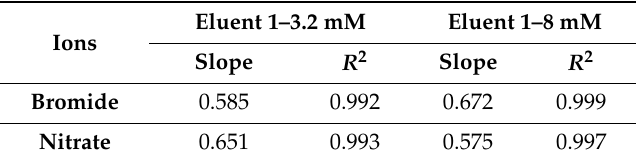
Table 1. Slopes and coe ffi cients of determination obtained for the calibration lines of bromide